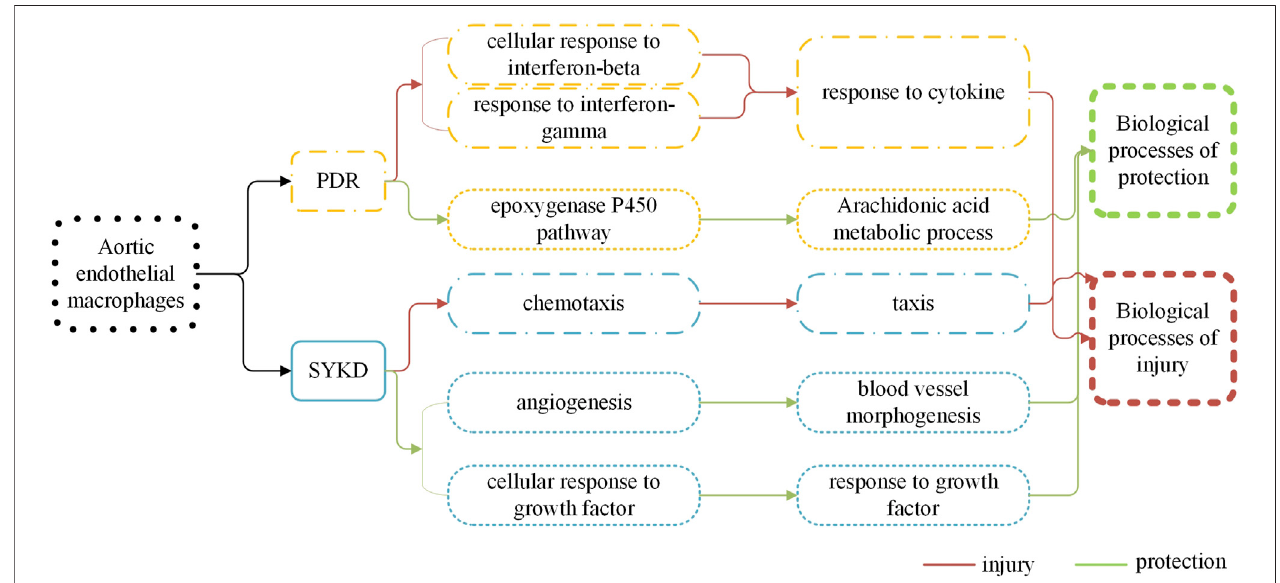
FIGURE 6 | There are different biological processes of macrophages in the dyslipidemia PDR syndrome group and the SKYD group.